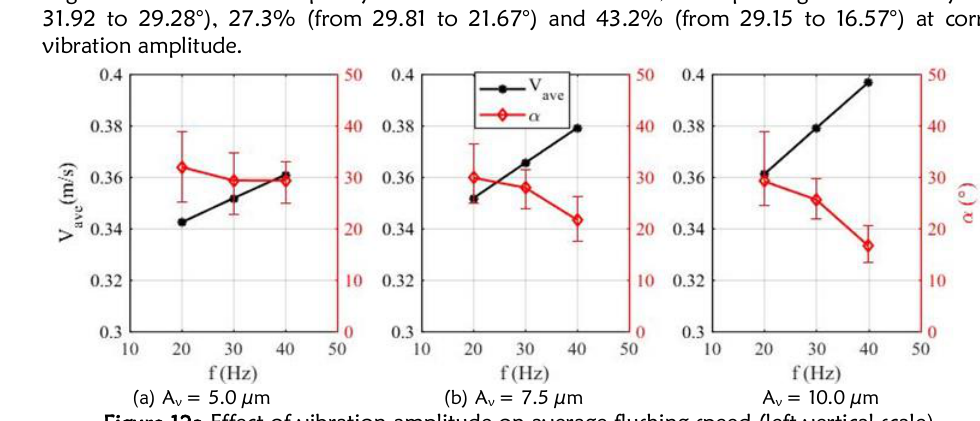
and taper angle (right vertical